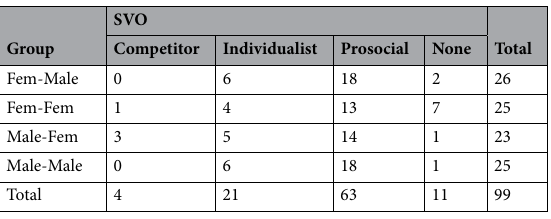
Table 1. SVO classification. SVO social value orientation by van Lange et al. 34